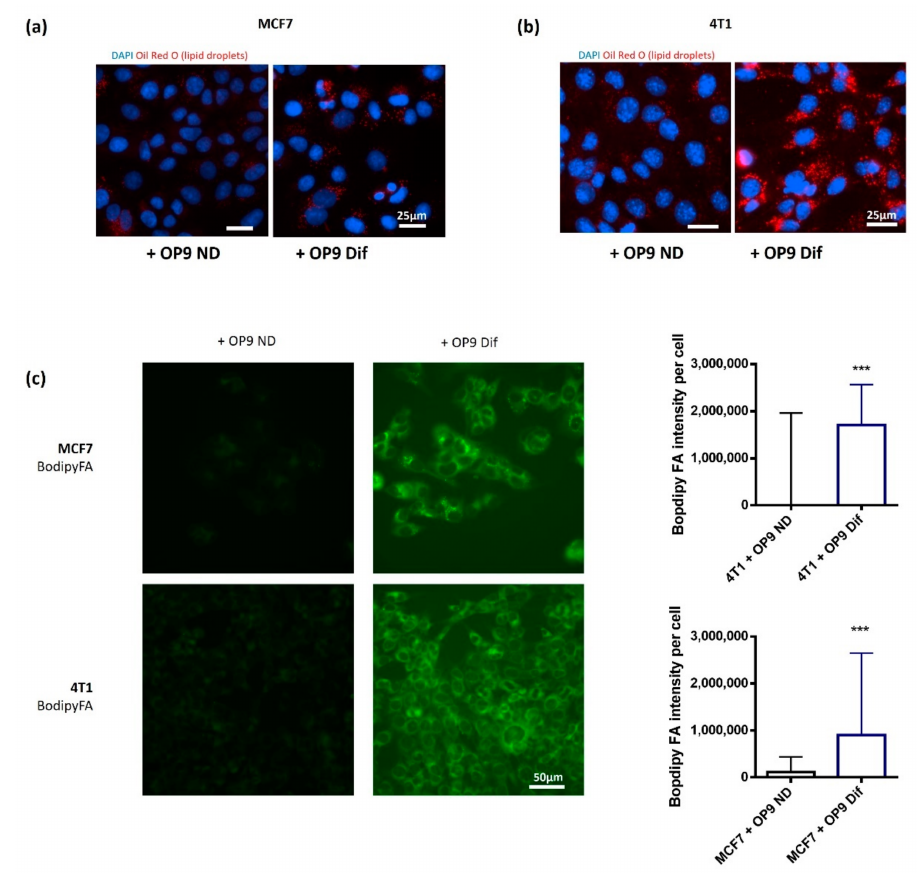
Figure 1. Co-culture with adipocytes increases lipid droplets in breast cancer cells. ( a , b ) Lipid droplets were stained using Oil Red O in MCF7 ( a ) and 4T1 ( a ) cells in co-culture with OP9 ND and OP9 Dif for 48 h. DAPI was used to normalise by cell number (representative of n = 6). ( c ) BODIPY FL C 16 in MCF7 and 4T1 breast cancer cells after 48 h of co-culture with BODIPY FL C 16 loaded OP9 ND and OP9 Dif (Median ± interquartile range, Mann–Whitney test *** p < 0.001, n =